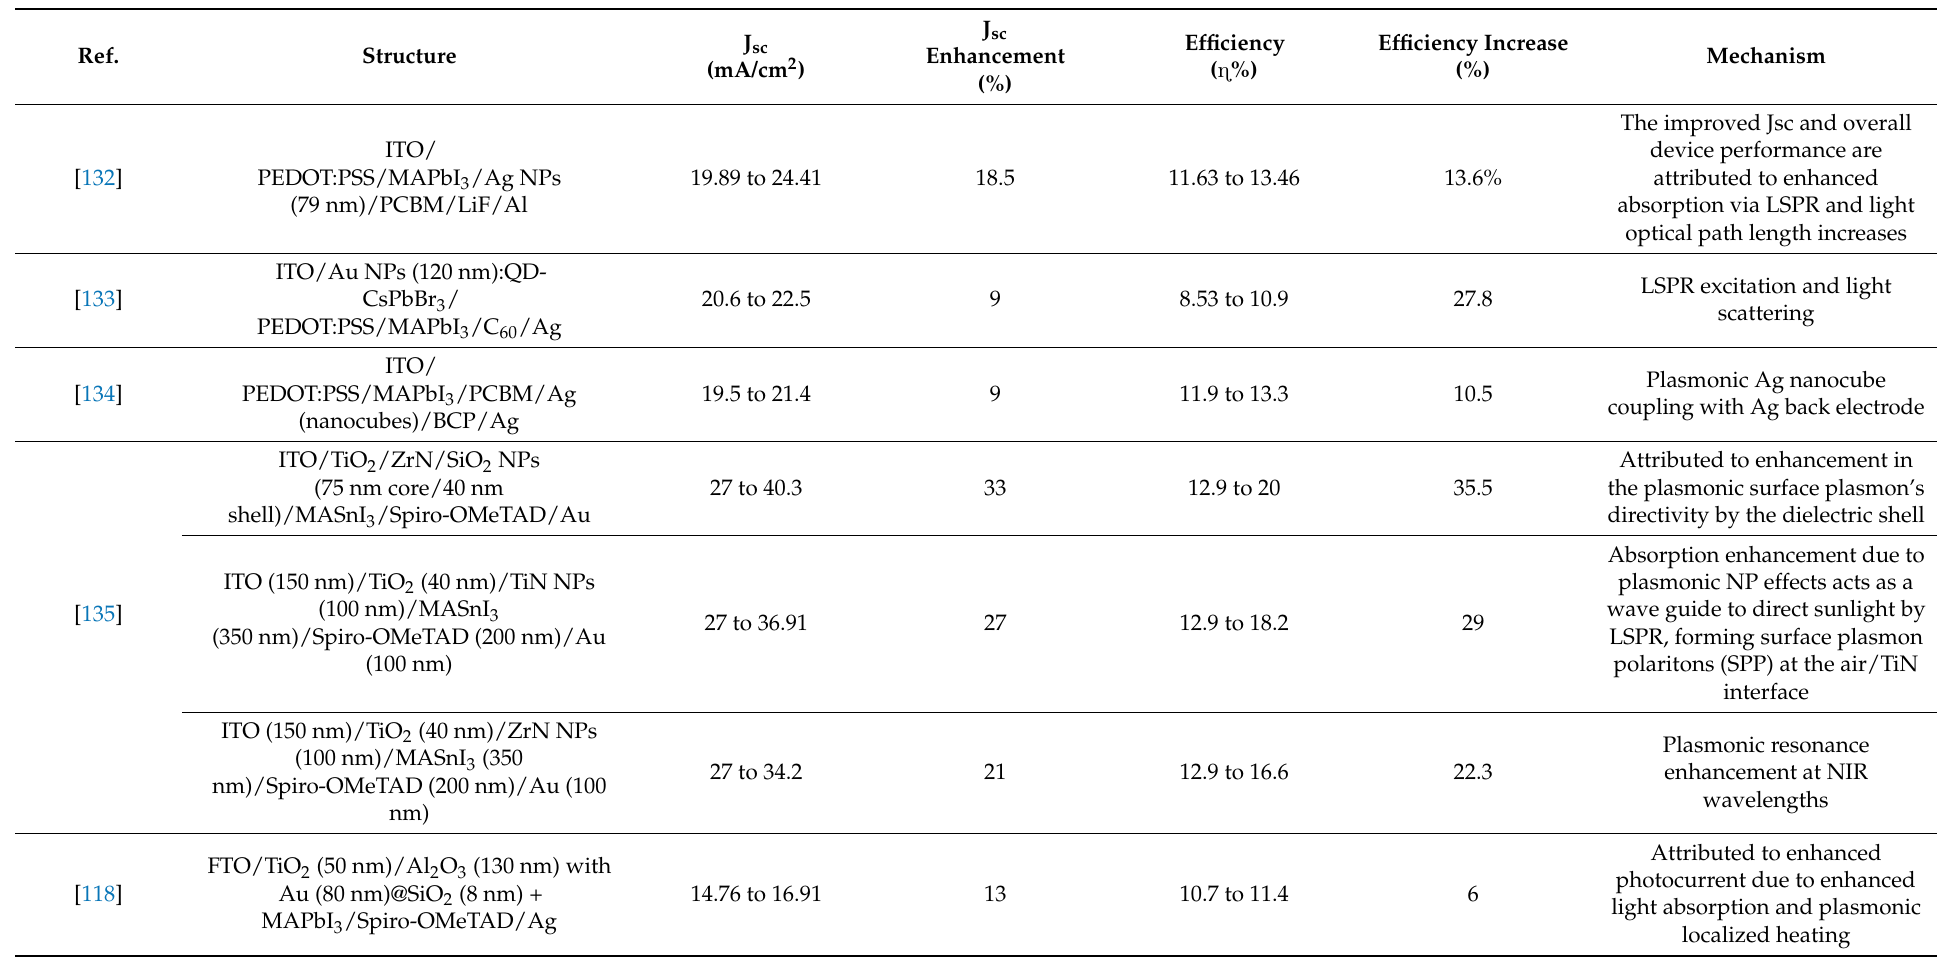
Table 9. Plasmonics nanoparticles applied in perovskite solar cells along with PV performances and mechanisms.